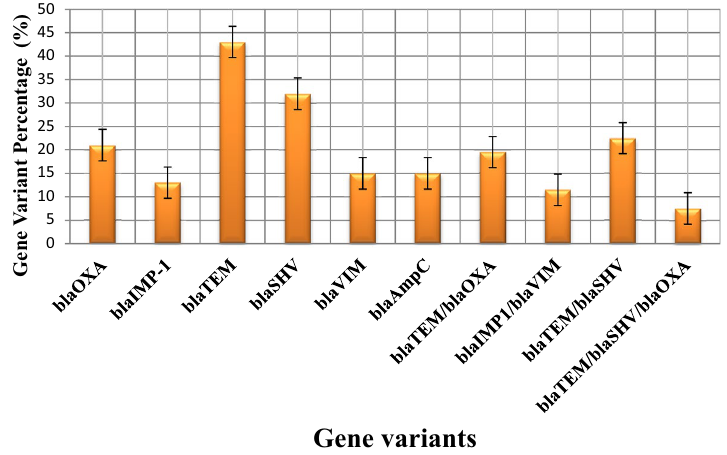
Figure 5. Co-expression of gene variants (MBL and ESBL) in isolates of Pseudomonas